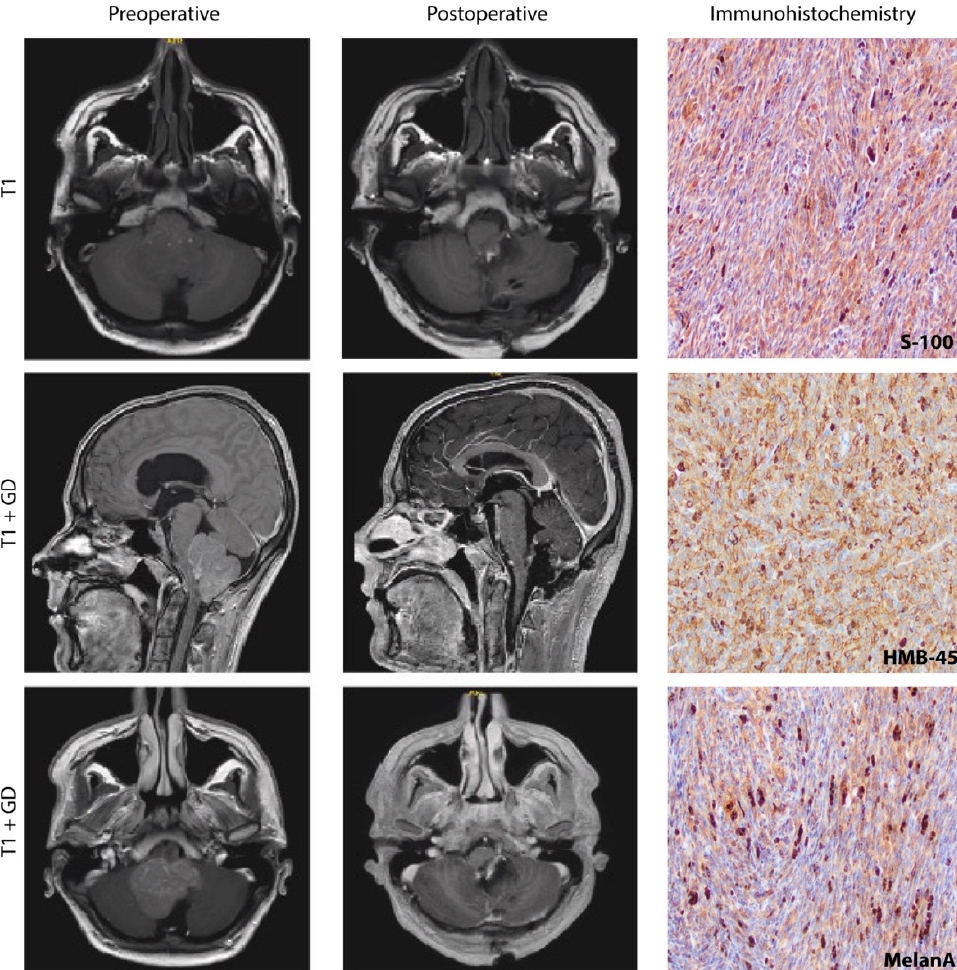
Figure 1. Exemplary perioperative MRI sequences of a 25-year-old Meningeal Melanocytoma (MM) patient that underwent surgery for a cerebellar lesion at our department. Axial T1 MRI showing a grey matter isointense posterior fossa mass shifting the brain stem forward, compressing cerebellum and brainstem, thereby leading to obstruction of the fourth ventricle. Preoperative ( left row ) T1 imaging after gadolinium application shows sagittal and axial inhomogeneous contrast enhancement. Postoperative ( middle row ) T1-weighted MRI without contrast agent (axial) and following gadolinium application (sagittal, axial), showing total resection of the mass with decompressed 4th ventricle and without secondary bleeding. Histopathological analysis of our case revealed spindle-shaped cells that showed expression of S-100, HMB45, and MelanA ( right row